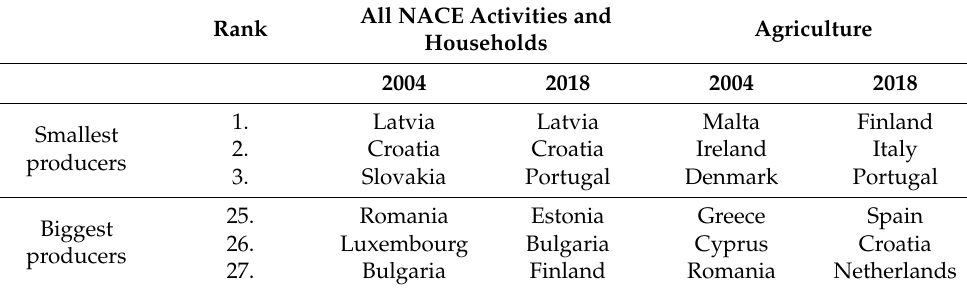
Table 1. Comparison of smallest and biggest waste producers. Rank